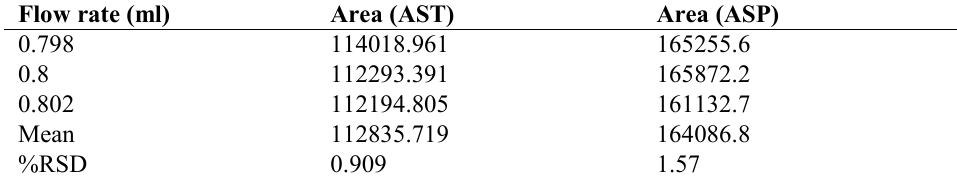
Table 7. Robustness for Flow rate Studies.